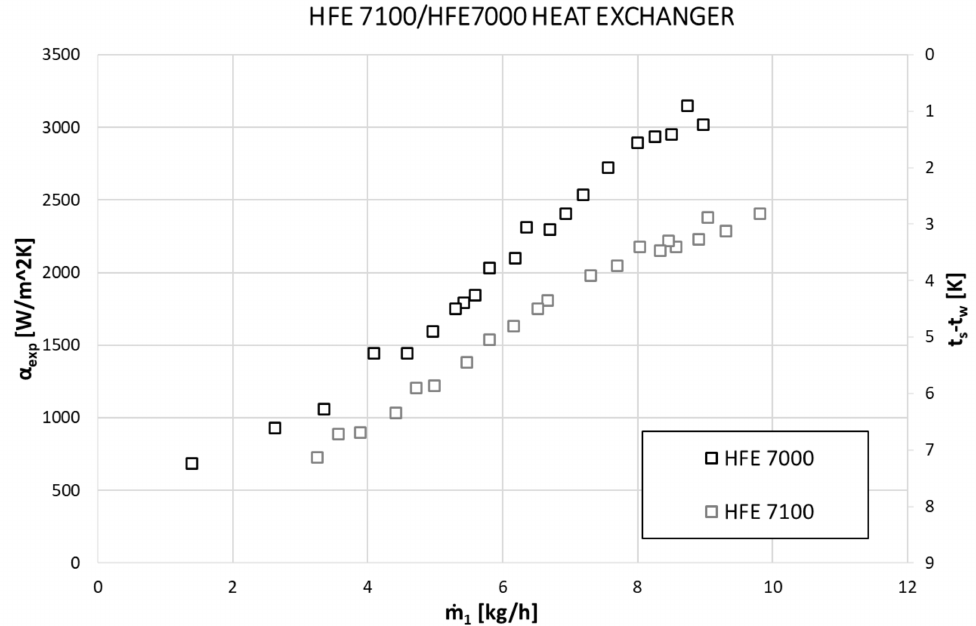
Figure 10. A comparison of experimental data of the heat transfer coefficient on the condensate velocity and condensate thickness during the HFE 7100 condensation process.